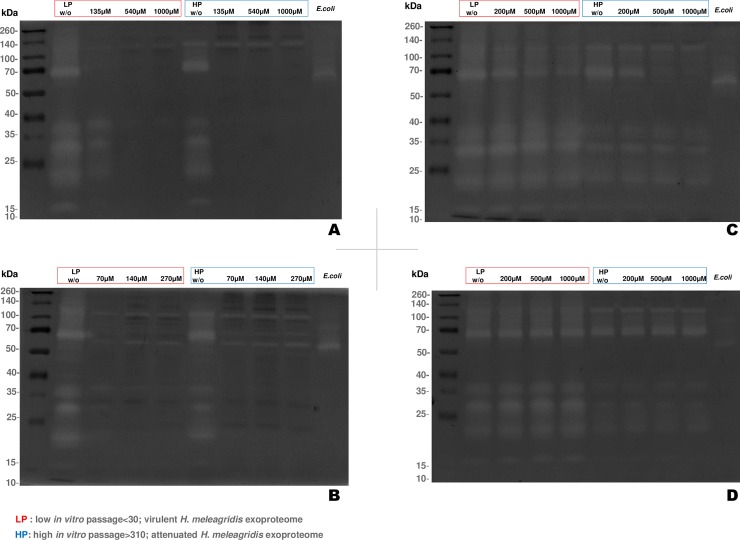
Dose dependent inhibitory effects of TLCK, E-64, PMSF and EDTA on the H. meleagridis exoproteomes.(A) 1D-IGZ demonstrating the inhibitory effect of TLCK (B), E-64 (C), PMSF and (D) EDTA. E. coli 24h exoproteome serves as a control due to its’ presence in monoxenic co-cultivation.